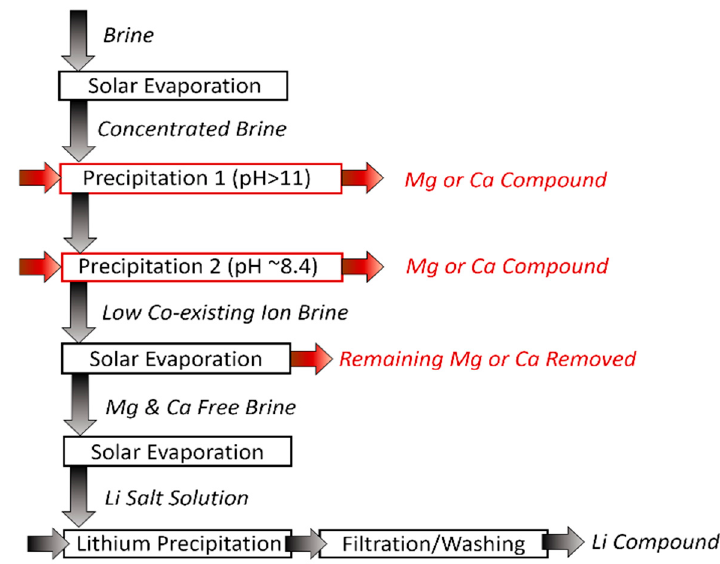
Figure 4. Precipitation schematic diagram.